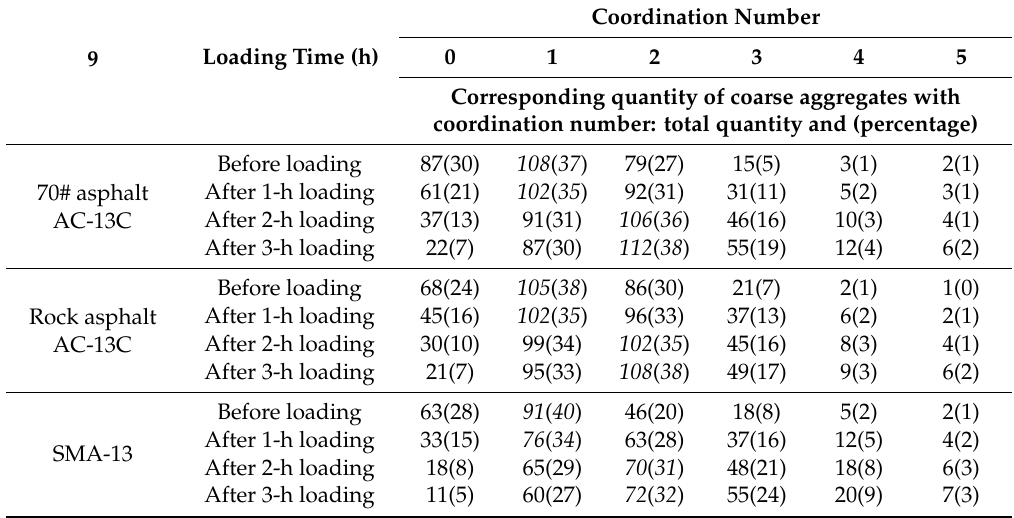
Table 9. Coordination number distribution at di ff erent loading